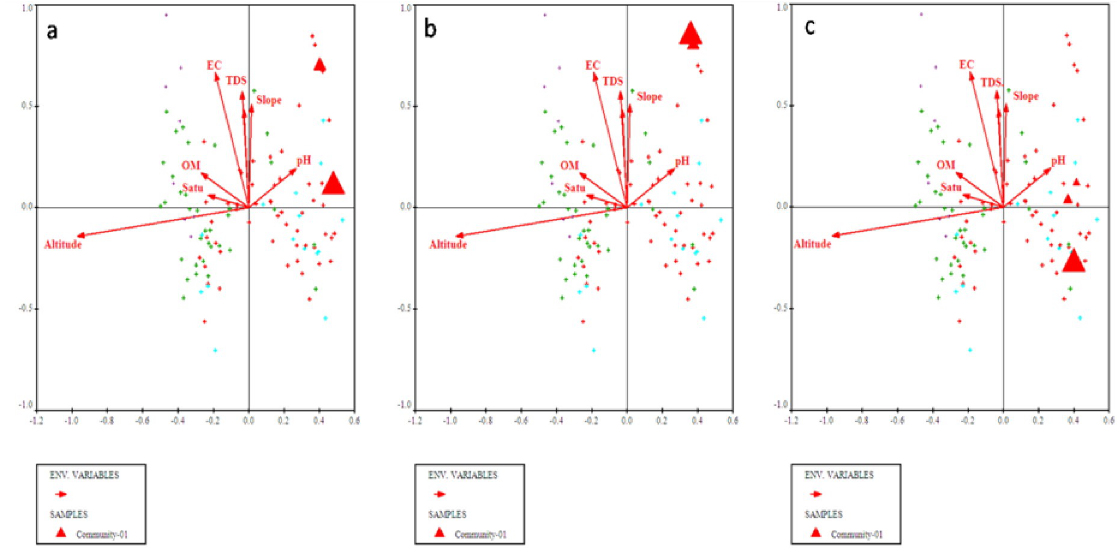
Fig 3. Bi-plots of (a) Olea ferruginea , (b) Desmodium elegans , and (c) Prunella vulgaris indicators along with measured environmental variables.